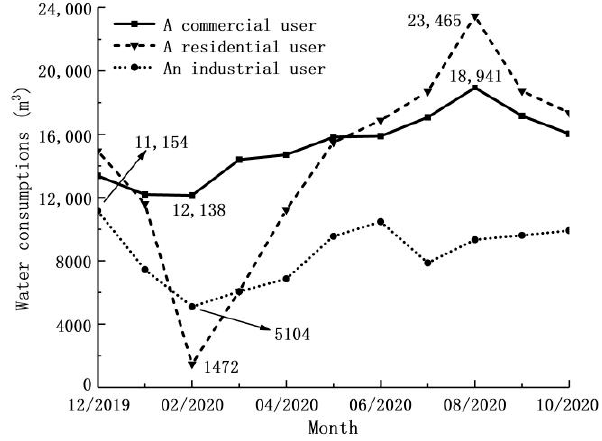
Figure 5. Comparison of total water consumption in different months.